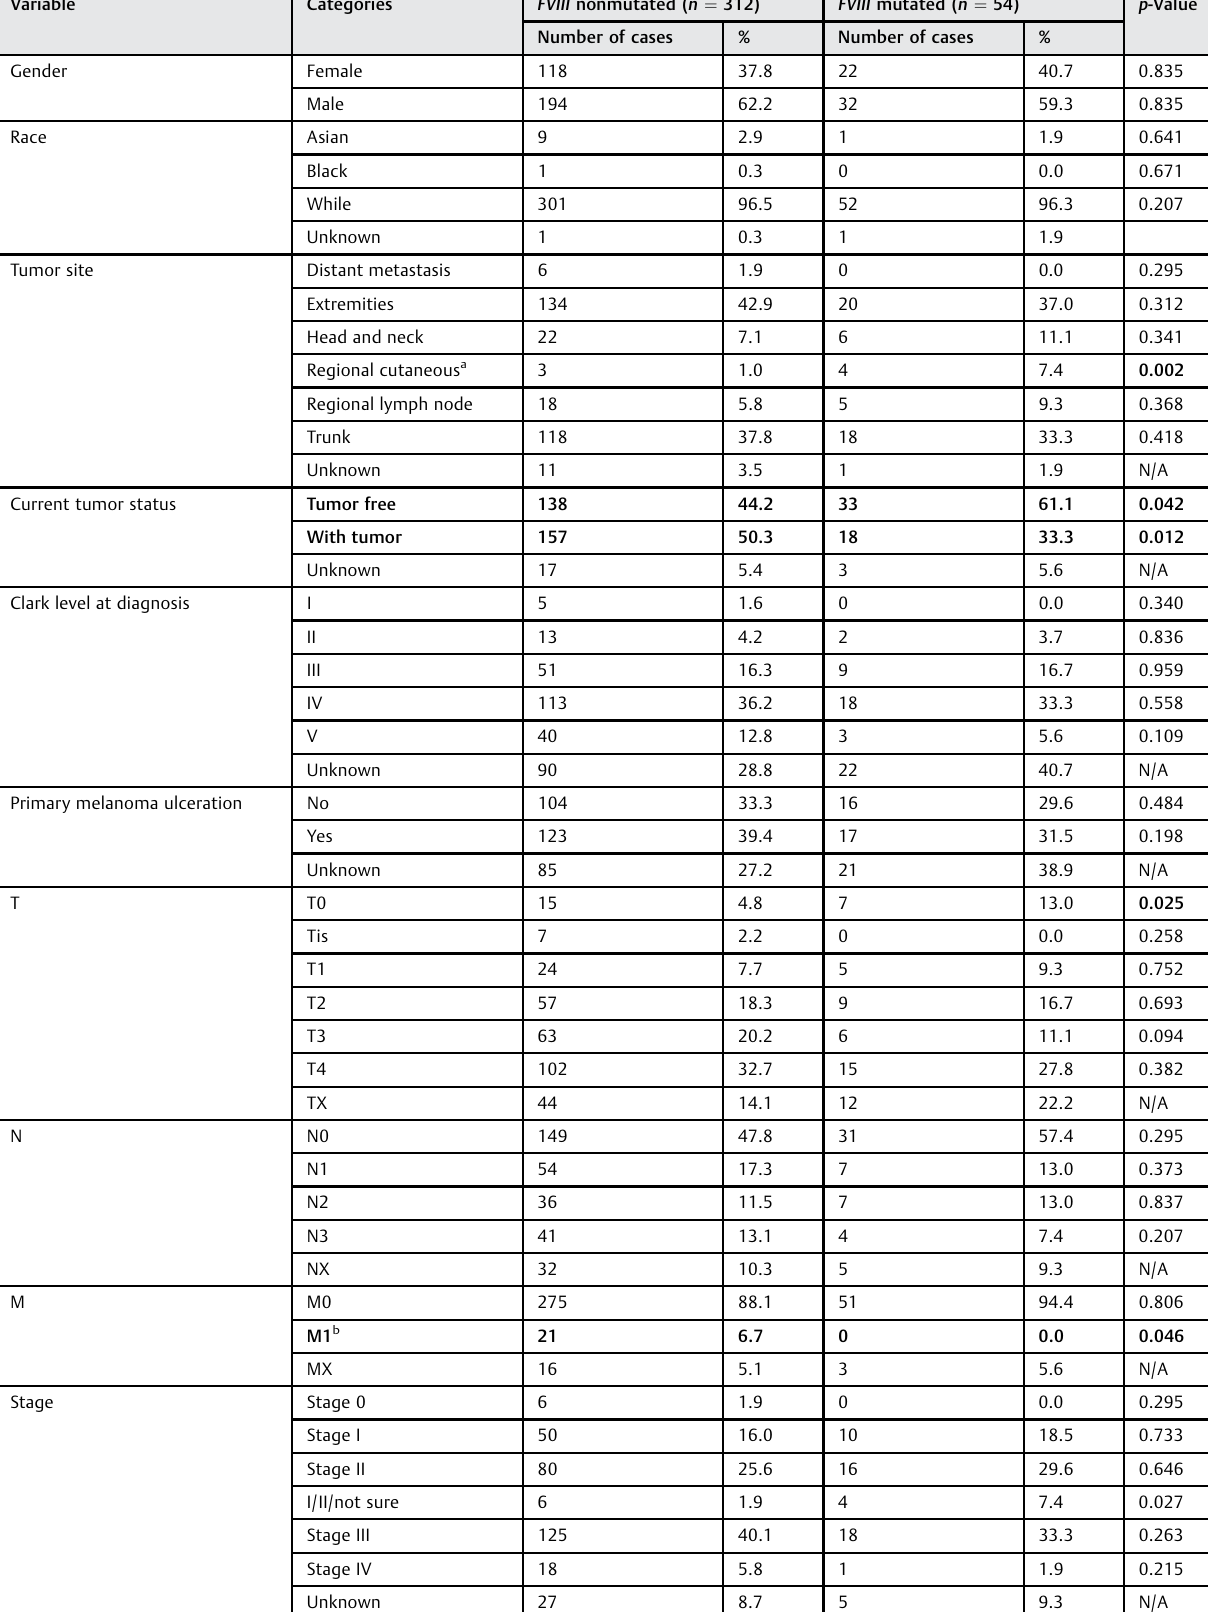
Table 1 Patient characteristics of categorical variables in FVIII -mutated and FVIII nonmutated groups Variable Gender